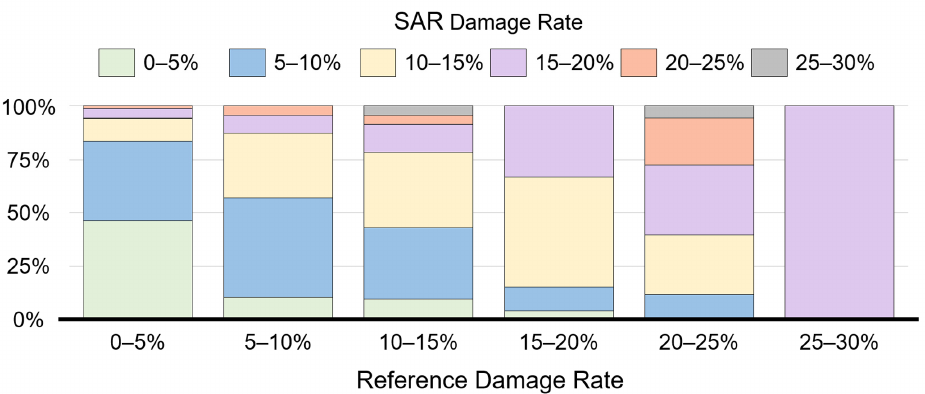
Figure 11. Comparison of SAR-based damage and reference damage rates.